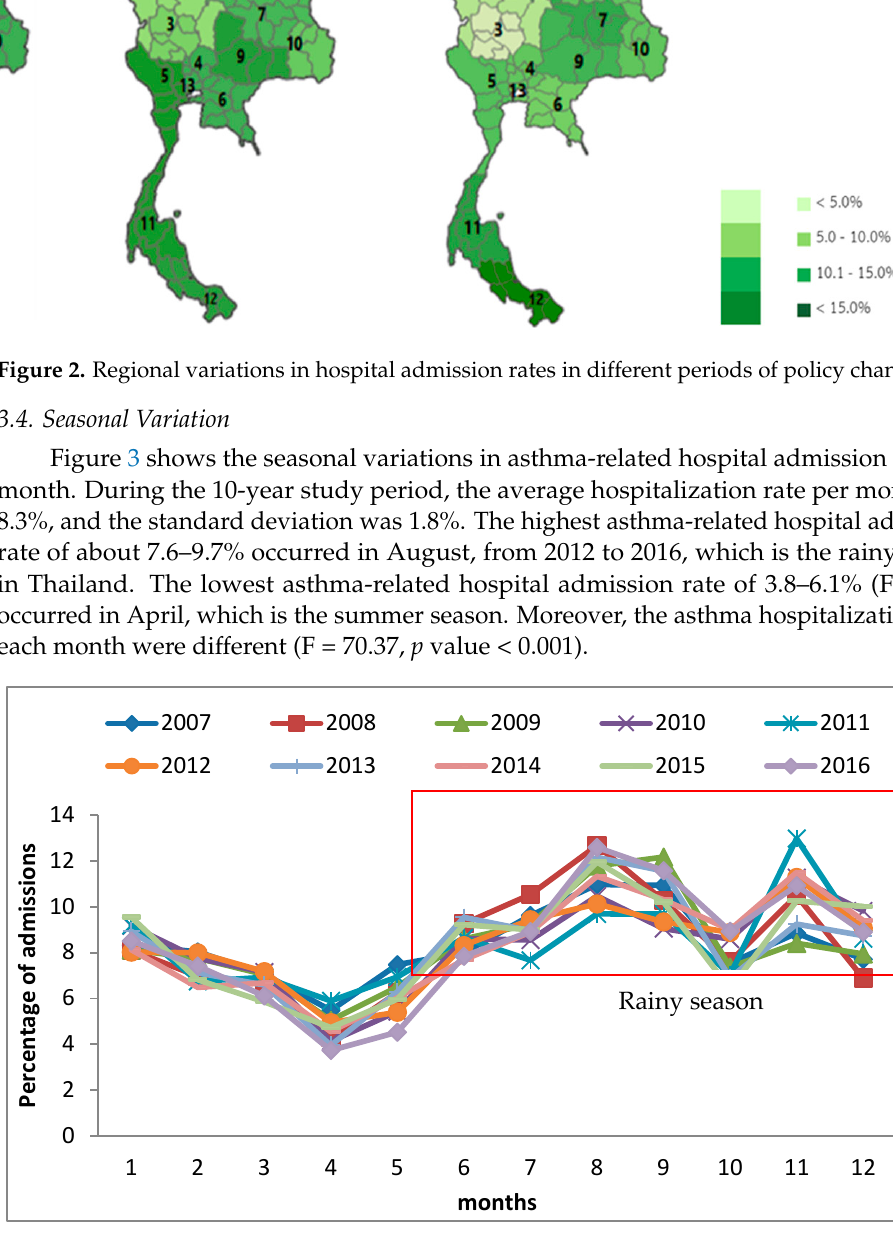
Figure 3. Seasonal variation in asthma-related hospital admissions rate by month.